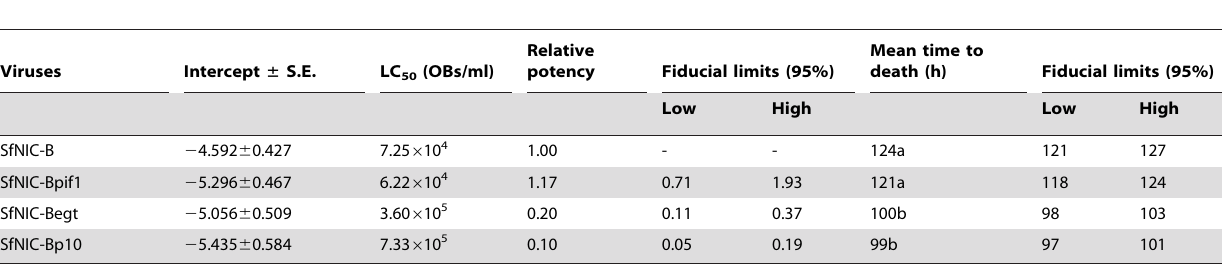
Table 2. Probit regression and time to death analysis for SfNIC-Bpif1, SfNIC-Begt and SfNIC-Bp10 recombinant viruses compared with the SfNIC-B parental virus in Spodoptera frugiperda second instars.